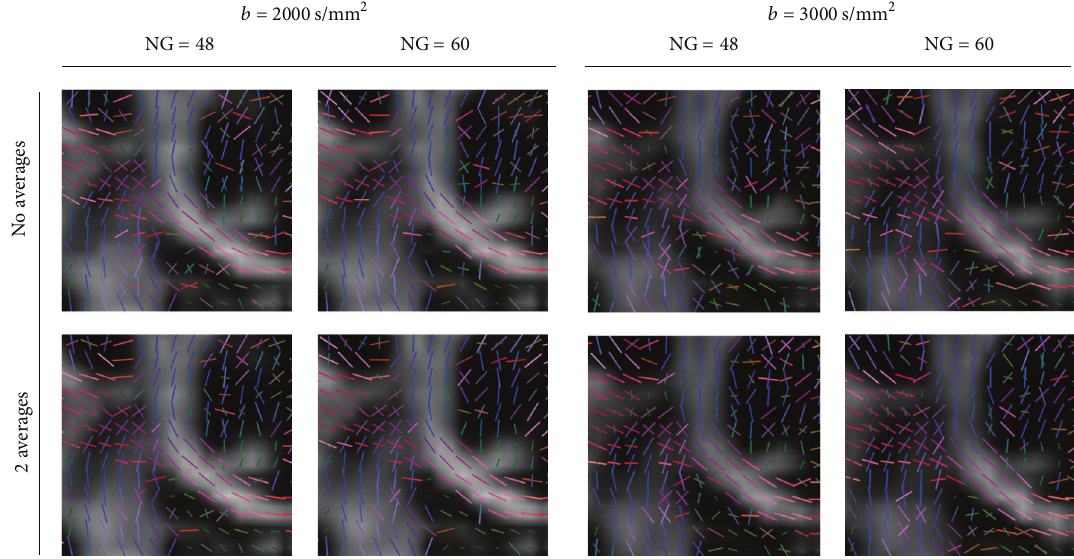
Figure 16: The effect of the averaging of the data at 𝑙 = 4 represented by the maxima detected from Q-ball glyphs. There is not a significant difference between the quality of the data without and with averaging even at higher 𝑏